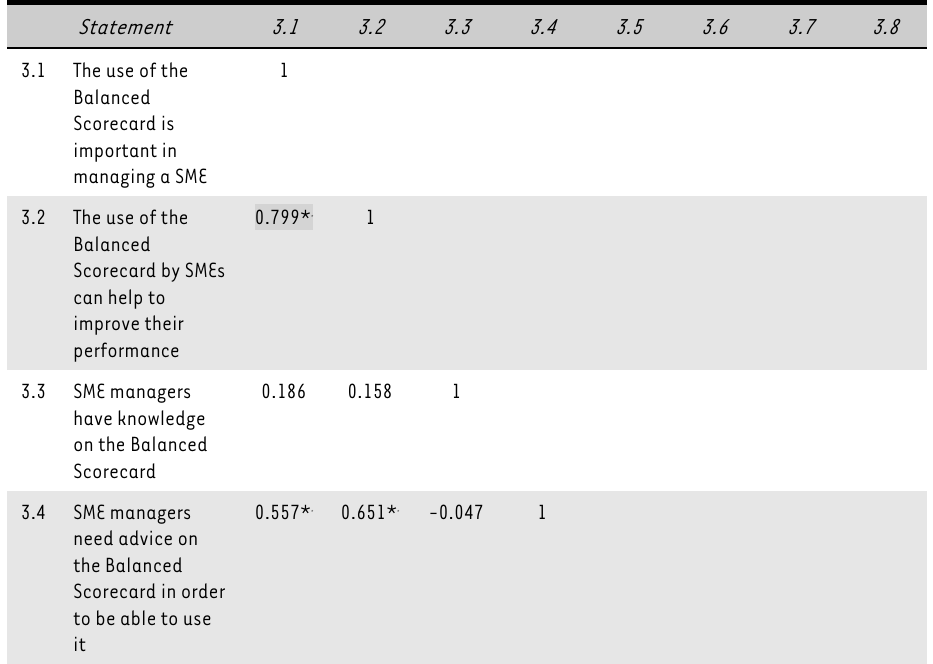
Spearman’s correlation coefficient: Balanced Scorecard (n =